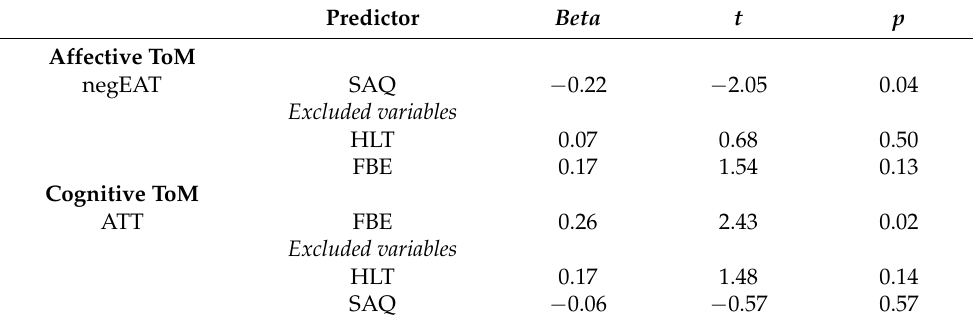
Table 3. Standardized regression coefficients predicting affective and cognitive ToM. Predictor Beta t